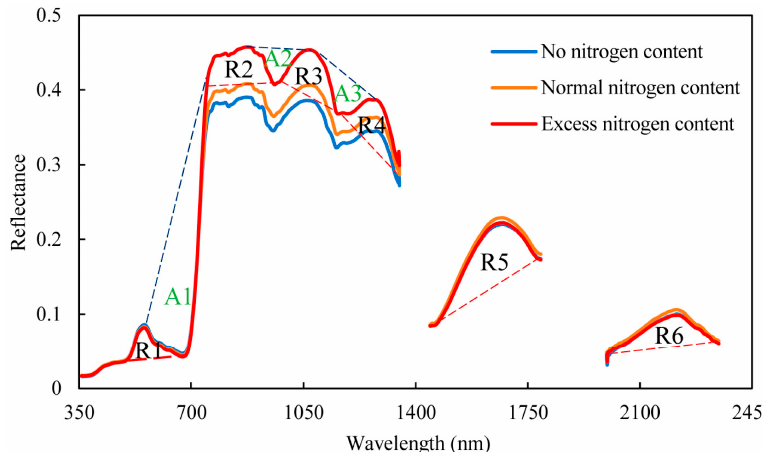
Figure 2. Characteristic (A) absorption and (R) reflection positions of the summer corn for the three nitrogen treatments. The red dotted line was the inner continuous line R ci ( λ max ) in the reflection position, the blue dotted line was outer continuum line R ci ( λ min ) in the absorption region.